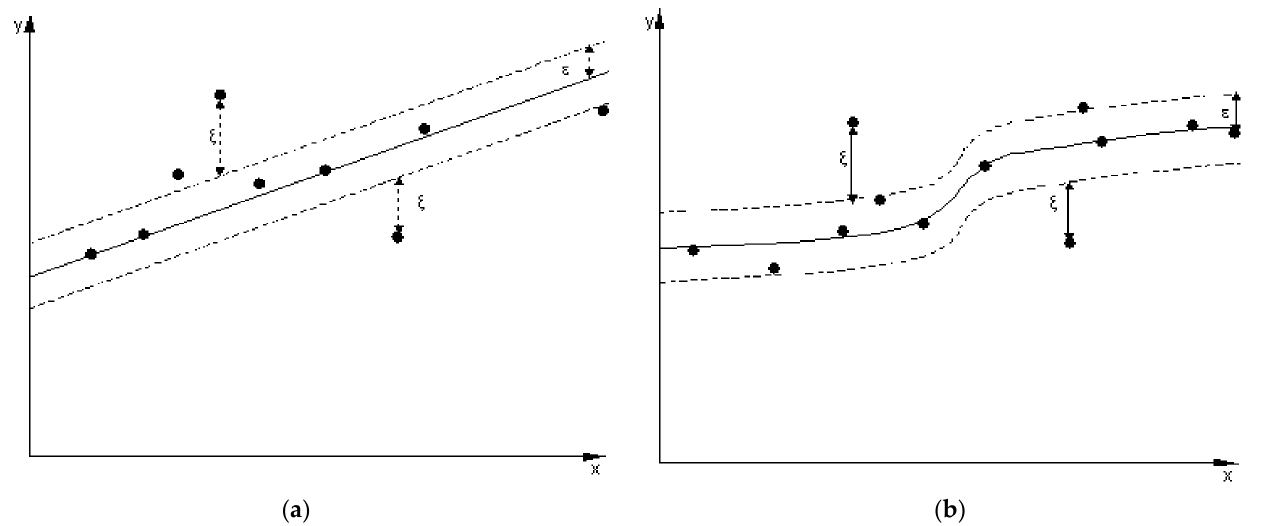
Figure 4. The epsilon-insensitive band via one-dimensional ( a ) linear regression function and ( b ) nonlinear regression function.